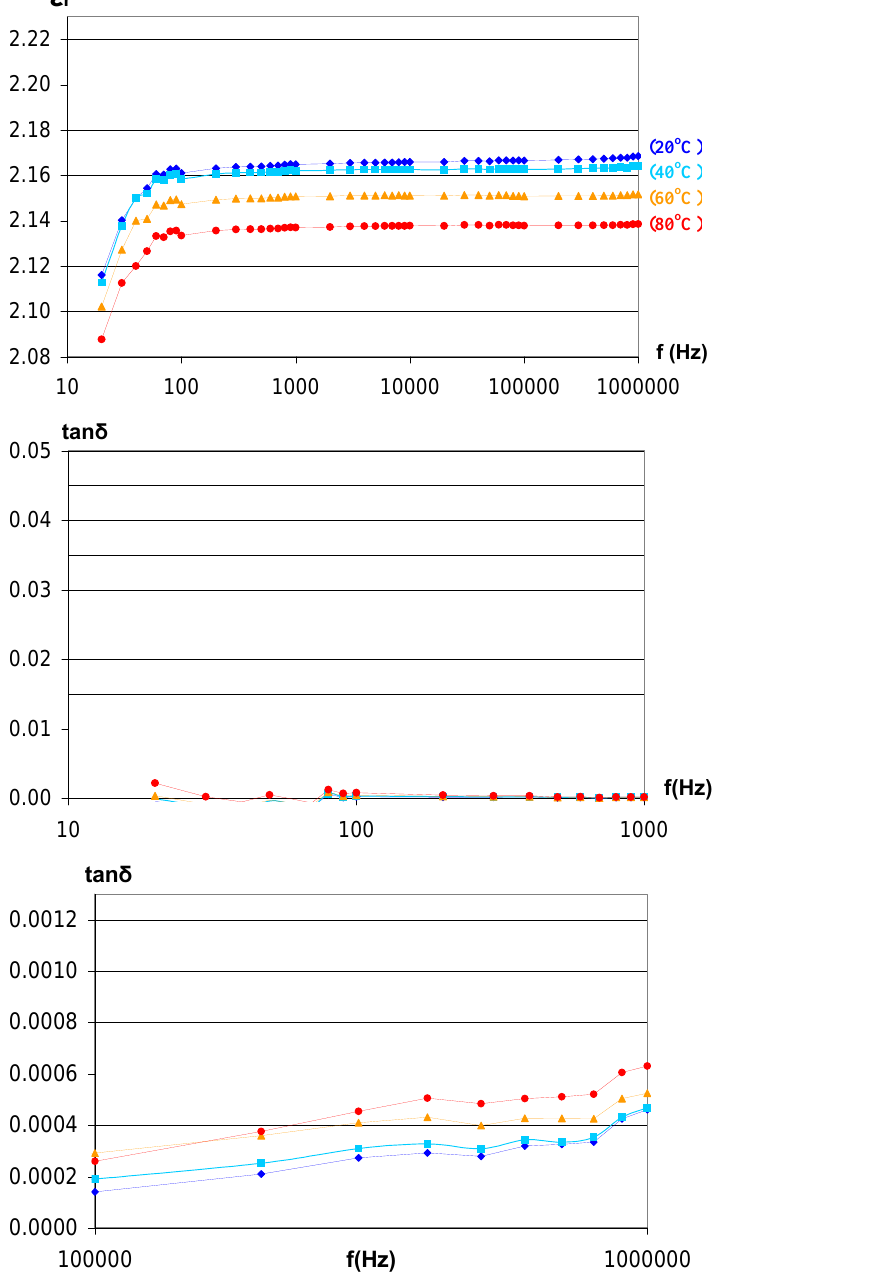
Figure 6. The dielectric spectroscopy data of the 90 power transformer oil samples classified in Group-I. (a) The average values for the relative dielectric constant ( ε function of the operating temperature and frequency. (b) The average values of all tan δ data of the Group-I samples, as a function of temperature in the frequency range: 20Hz – 1kHz. (c) The average values of all tan δ data of the Group-I samples, as a function of temperature in the frequency range: 100 kHz – 1